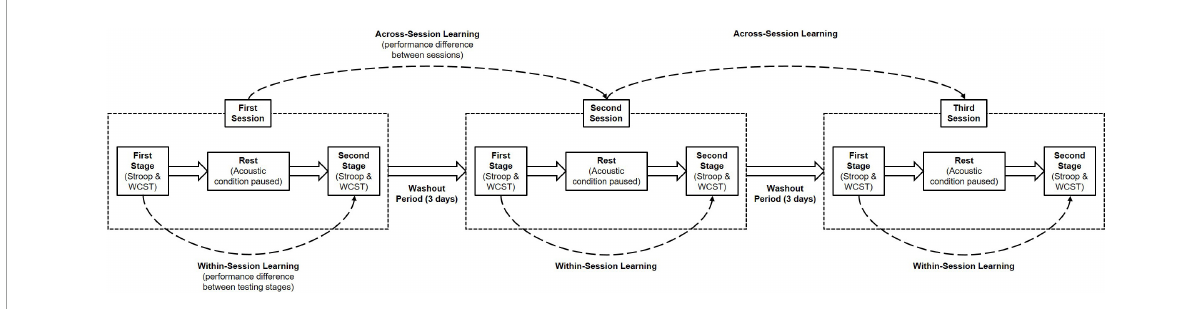
FIGURE1 Experimental protocol for assessing the effects of background acoustic conditions on cognitive functions. Participants performed both the Stroop test and Wisconsin card sorting test in three separate daily sessions, each separated by a 3-day washout period. Within a daily session there were two testing stages, where each test was completed once over, separated by a ten-minute rest period. A different background acoustic condition was played in each daily session. This protocol allows for the assessment of within-session learning (the behavioural changes occurring between the first and second testing stages in the same daily session). The order of both background acoustic conditions and task performance was counterbalanced across the three daily sessions, accounting for the influence of across-session